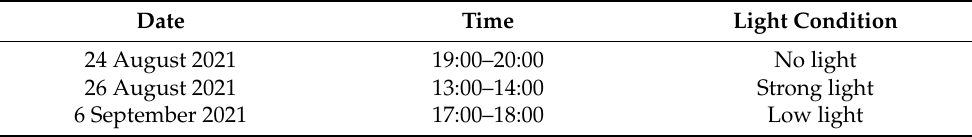
Figure 2. Aerial view of experimental pear orchards: ( a ) conventional planted pear orchard, and ( b ) joint-tree training pear orchard in the Tsukuba-Plant Innovation Research Center (T-PIRC), Univer- sity of Tsukuba, Japan. Table 1. Dataset collection times and light conditions in